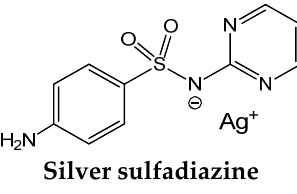
Figure 1. Examples of silver compounds with antibacterial properties.